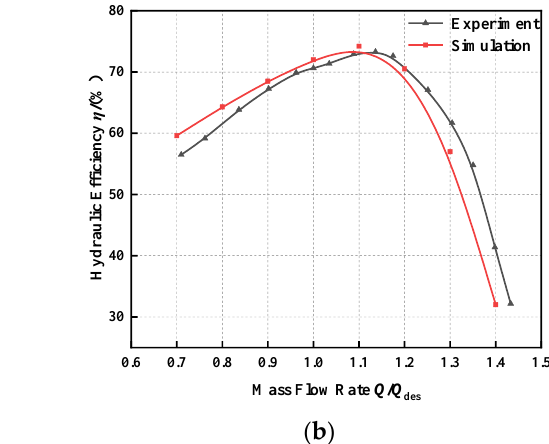
Figure 9. Comparison between numerical simulation and model test of hydraulic performance: ( a ) flow head performance curve; ( b ) flow efficiency performance curve.